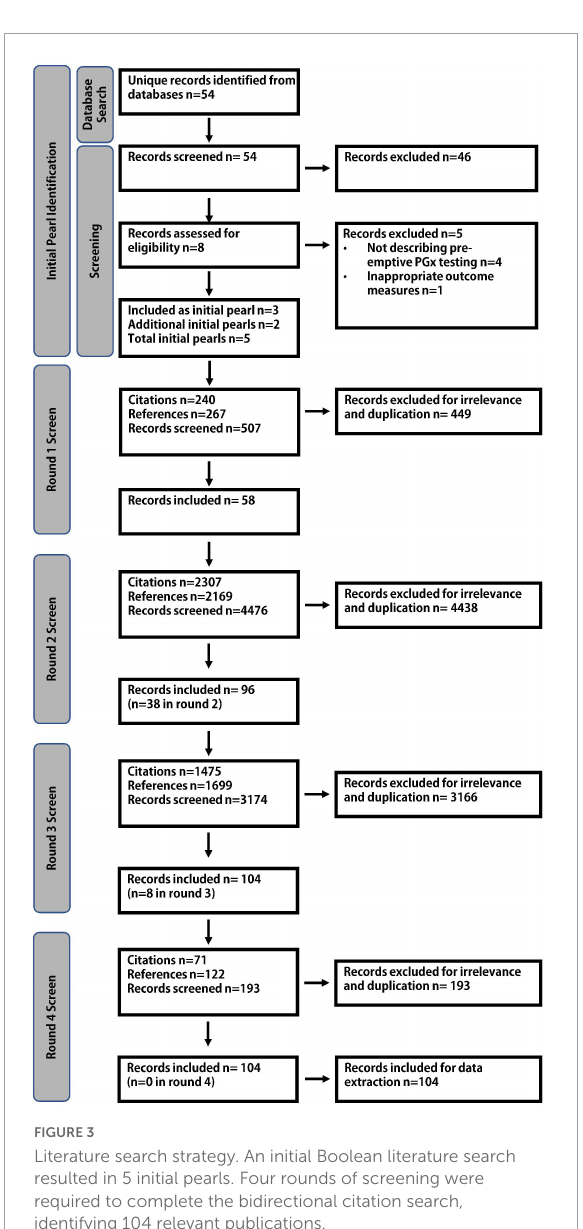
FIGURE3 Literature search strategy. An initial Boolean literature search resulted in 5 initial pearls. Four rounds of screening were required to complete the bidirectional citation search, identifying 104 relevant